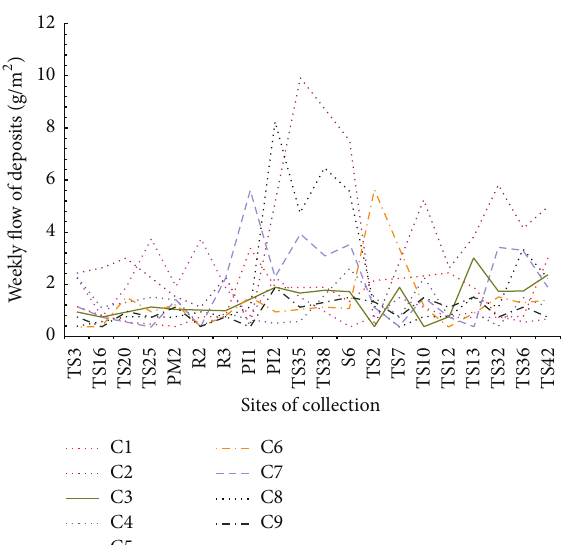
Figure3:Spatialvariationofdepositsparticlesfluxesabovethesolar saltern.